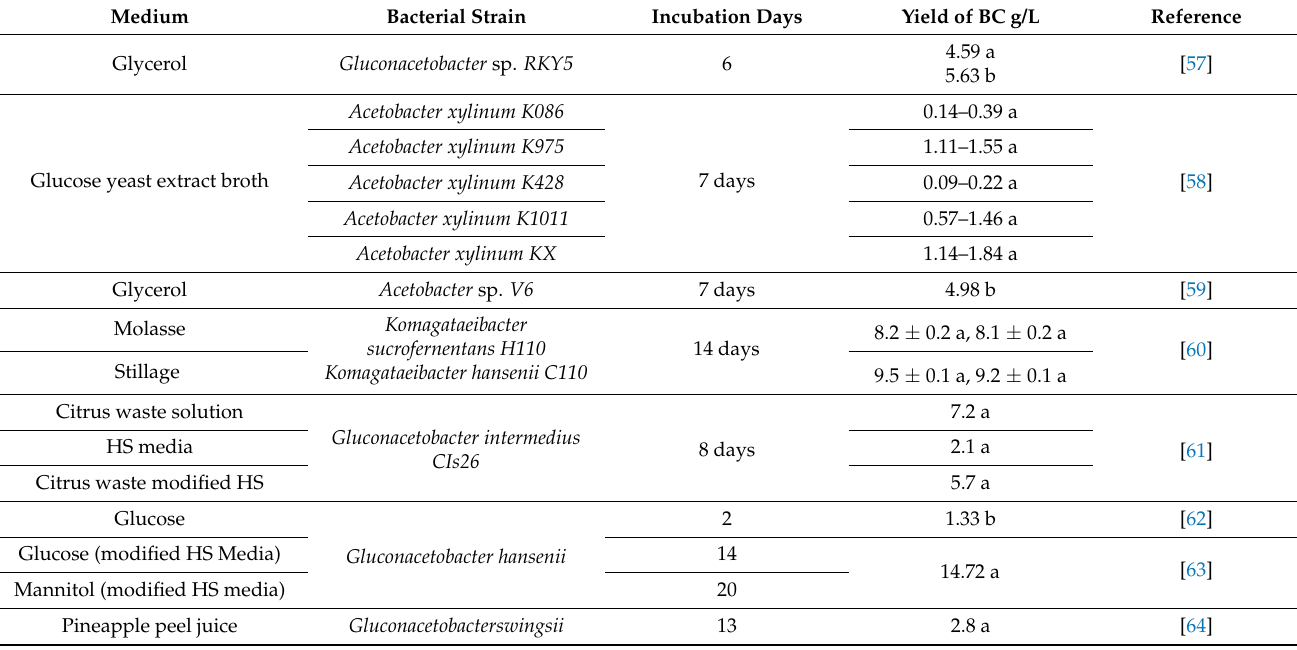
Table 1. Yield of BC with the variation of bacterial strains, culture medium, and cultivation